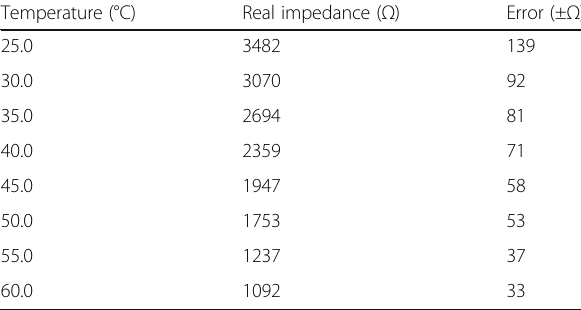
Table 1 Real impedance values ( Ω ) of pure water as a